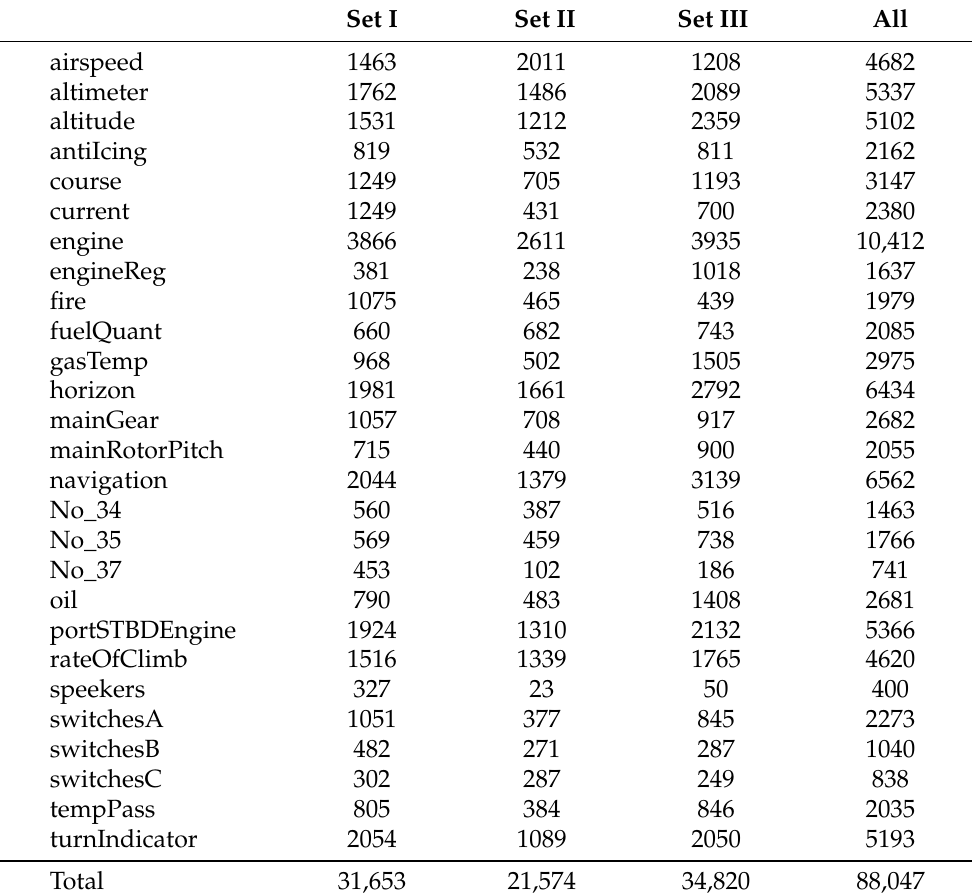
Table 2. Number of elements in classes of the WrightBroS